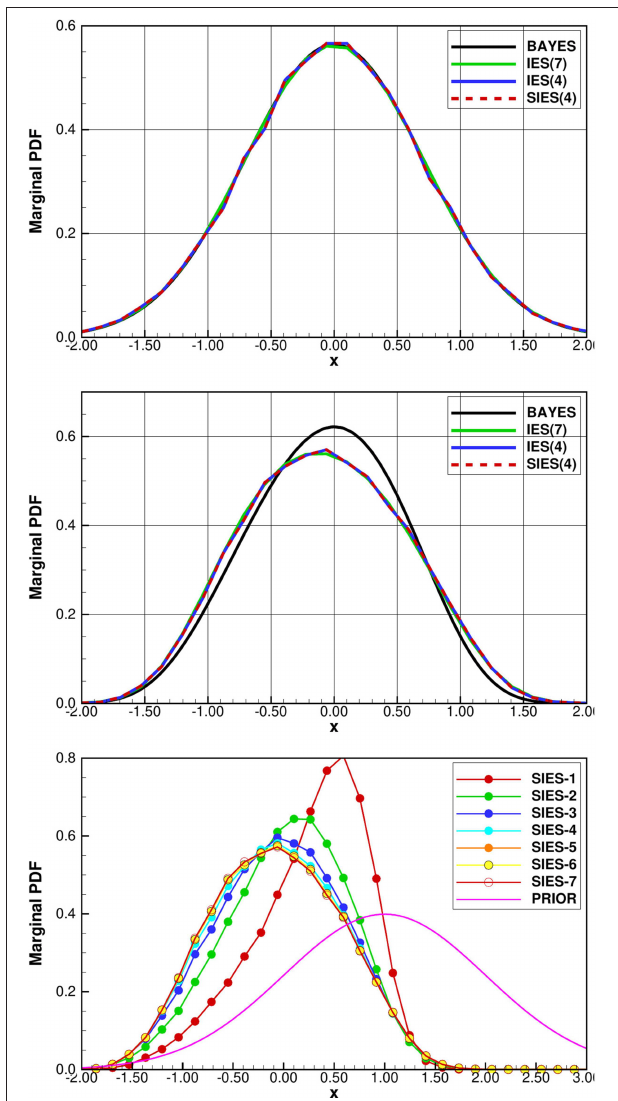
FIGURE 2 | Scalar model: IES and SIES solutions in the linear case (upper plot) and non-linear case (middle plot). The same random seed is used in all experiments. The black pdf is the theoretical solution defined by Bayes’. The green pdf, denoted IES(7) is the converged IES solution using 10 7 realizations. The blue pdf denoted IES(4) is the IES solution using with 40,000 realizations, and it is exactly equal to the red dashed pdf denoted SIES(4), which is the SIES with 40,000 realizations. The lower plot shows SIES iterations in the non-linear case using 40,000 realizations. After 6 iterations the pdfs are